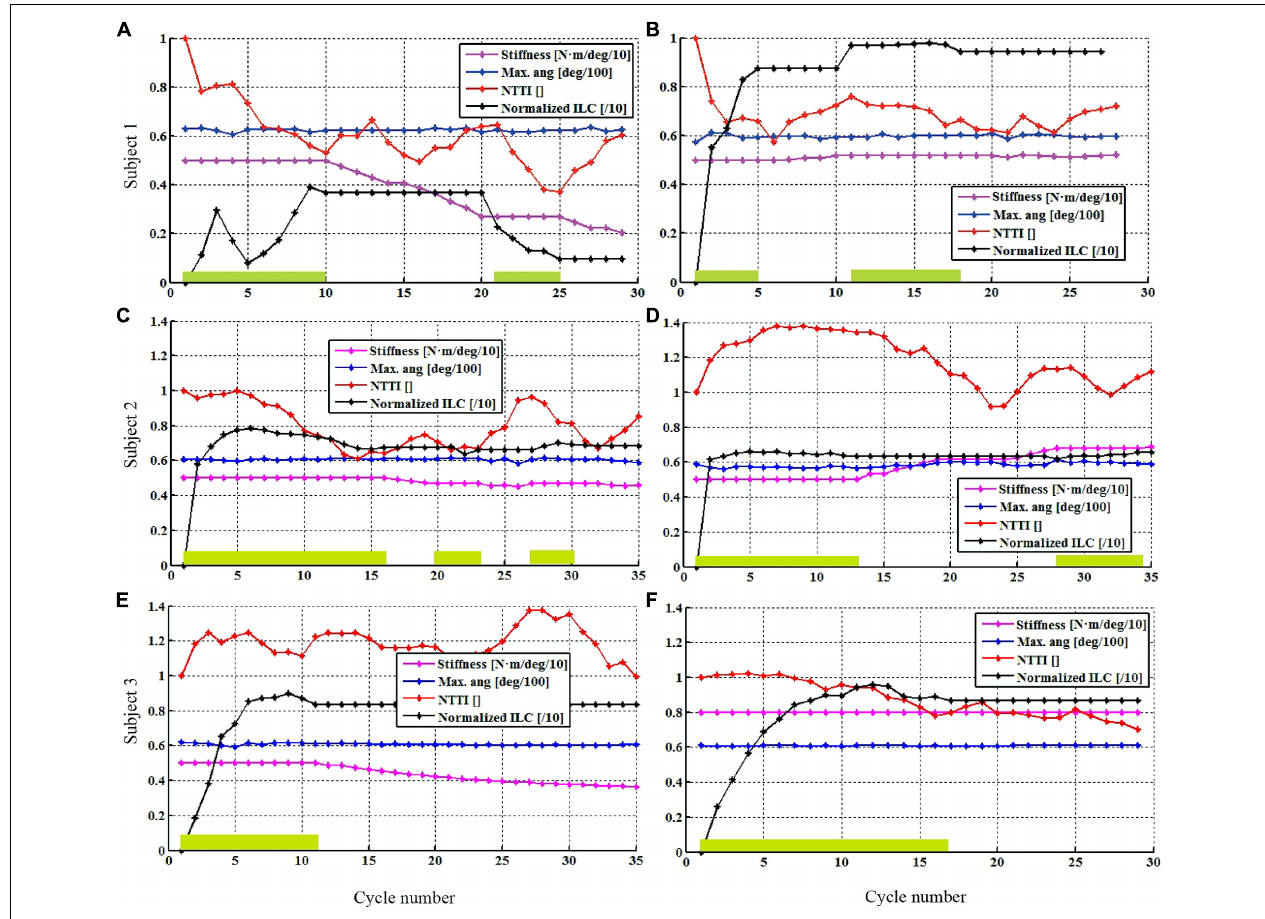
FIGURE 4 | Single-subject performance in the cycle domain during the HC condition. Controller stiffness (magenta line), NTTI (red), maximum angle achieved during flexion (blue line), normalized torque-time integral (red line), and NILC (black line) of left (A,C,E)